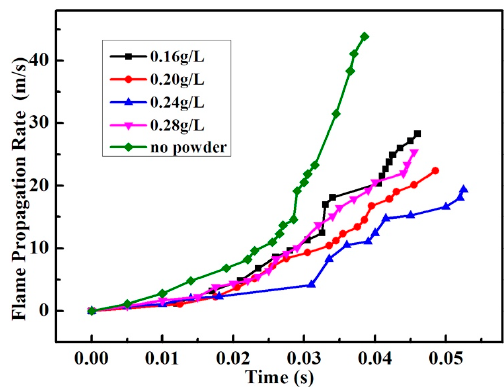
Figure 9. The average velocity of flame propagation of the 9.5% methane-air premixed gas explosion with different concentrations of pristine palygorskite powders.